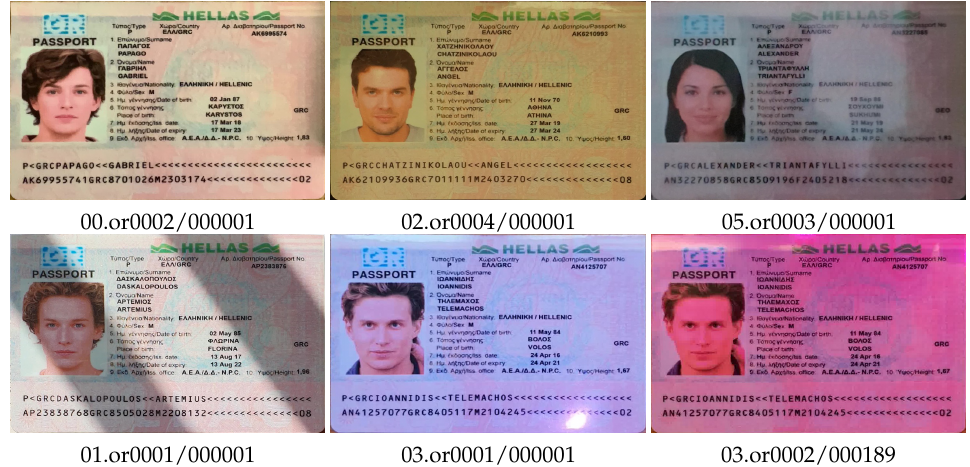
Figure 2. Color variation of original document images for a variety of capture conditions, type grc_passport.